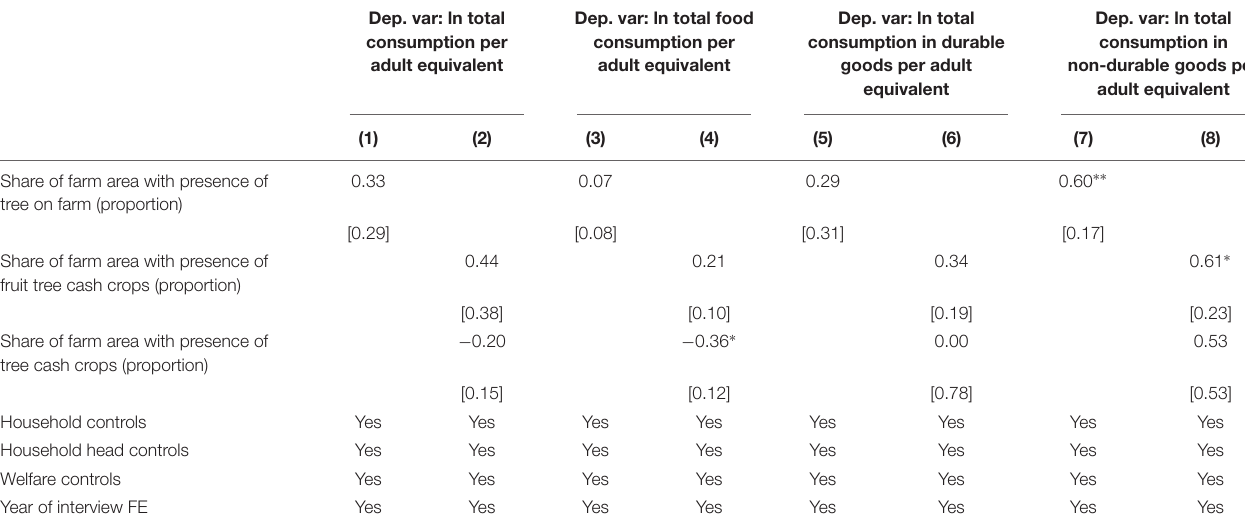
TABLE 5 | Fixed-effects model results on household consumption and trees on farms adoption (including bananas as a fruit tree). Dep. var: ln total consumption